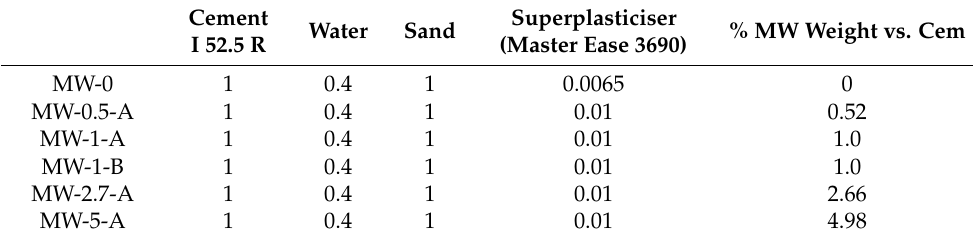
Table 1. Mixes cast with different amounts of mask waste (MW). Cement Water I 52.5 R